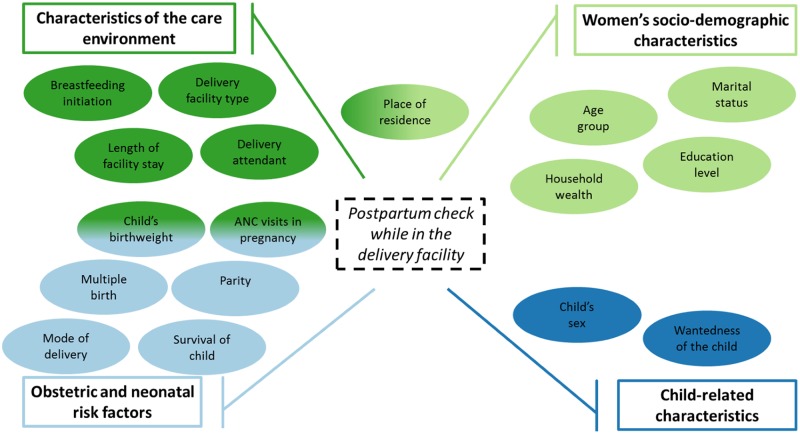
Percentage of women reporting receiving a postpartum check while in the facility following childbirth, by country and question pattern (A, light blue; B, dark blue; C, brown).ANC, antenatal care.